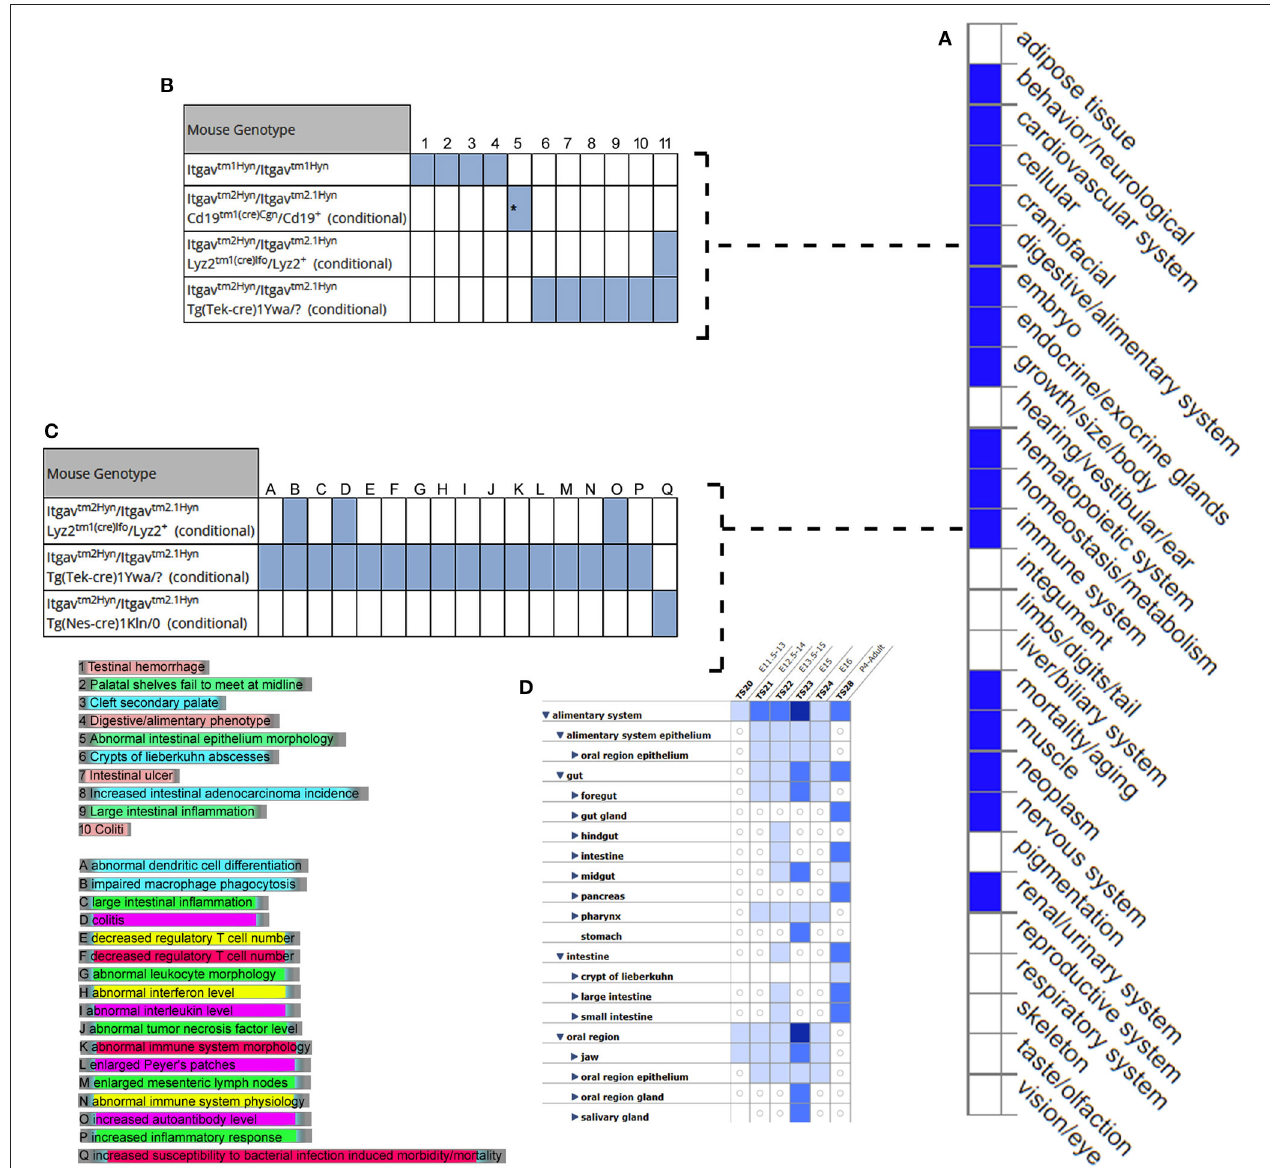
FIGURE 6 | Expression and phenotype characteristics demonstrated by ITGAV knockout mice from Mouse Genome Informatics (MGI) database. (A) System level Mammalian phenotype effect are displayed. Blue boxes represent abnormal phenotypes and blank boxes represent the normal phenotype for ITGAV mutants in that system. (B,C) Tables represent the most genotype affect relevant pathways in (B) digestive/alimentary system (C) immune system. (D) ITGAV expression in alimentary canal system. Shades of blue color in the grid indicate the detection of the variable expression level, dark blue > 50, blue 5–10, light blue 1–4 annotations.